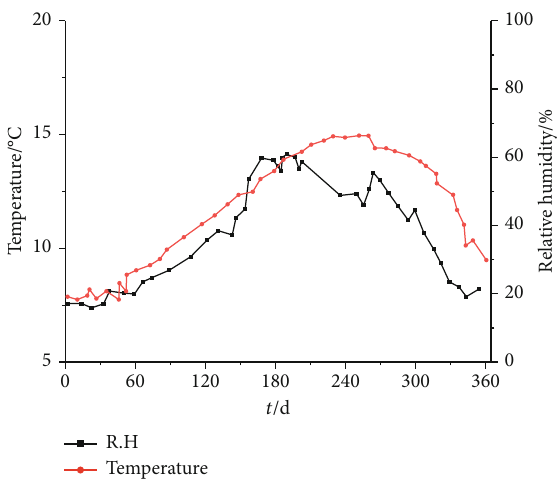
Figure 3: Annual environmental monitoring curve in hole